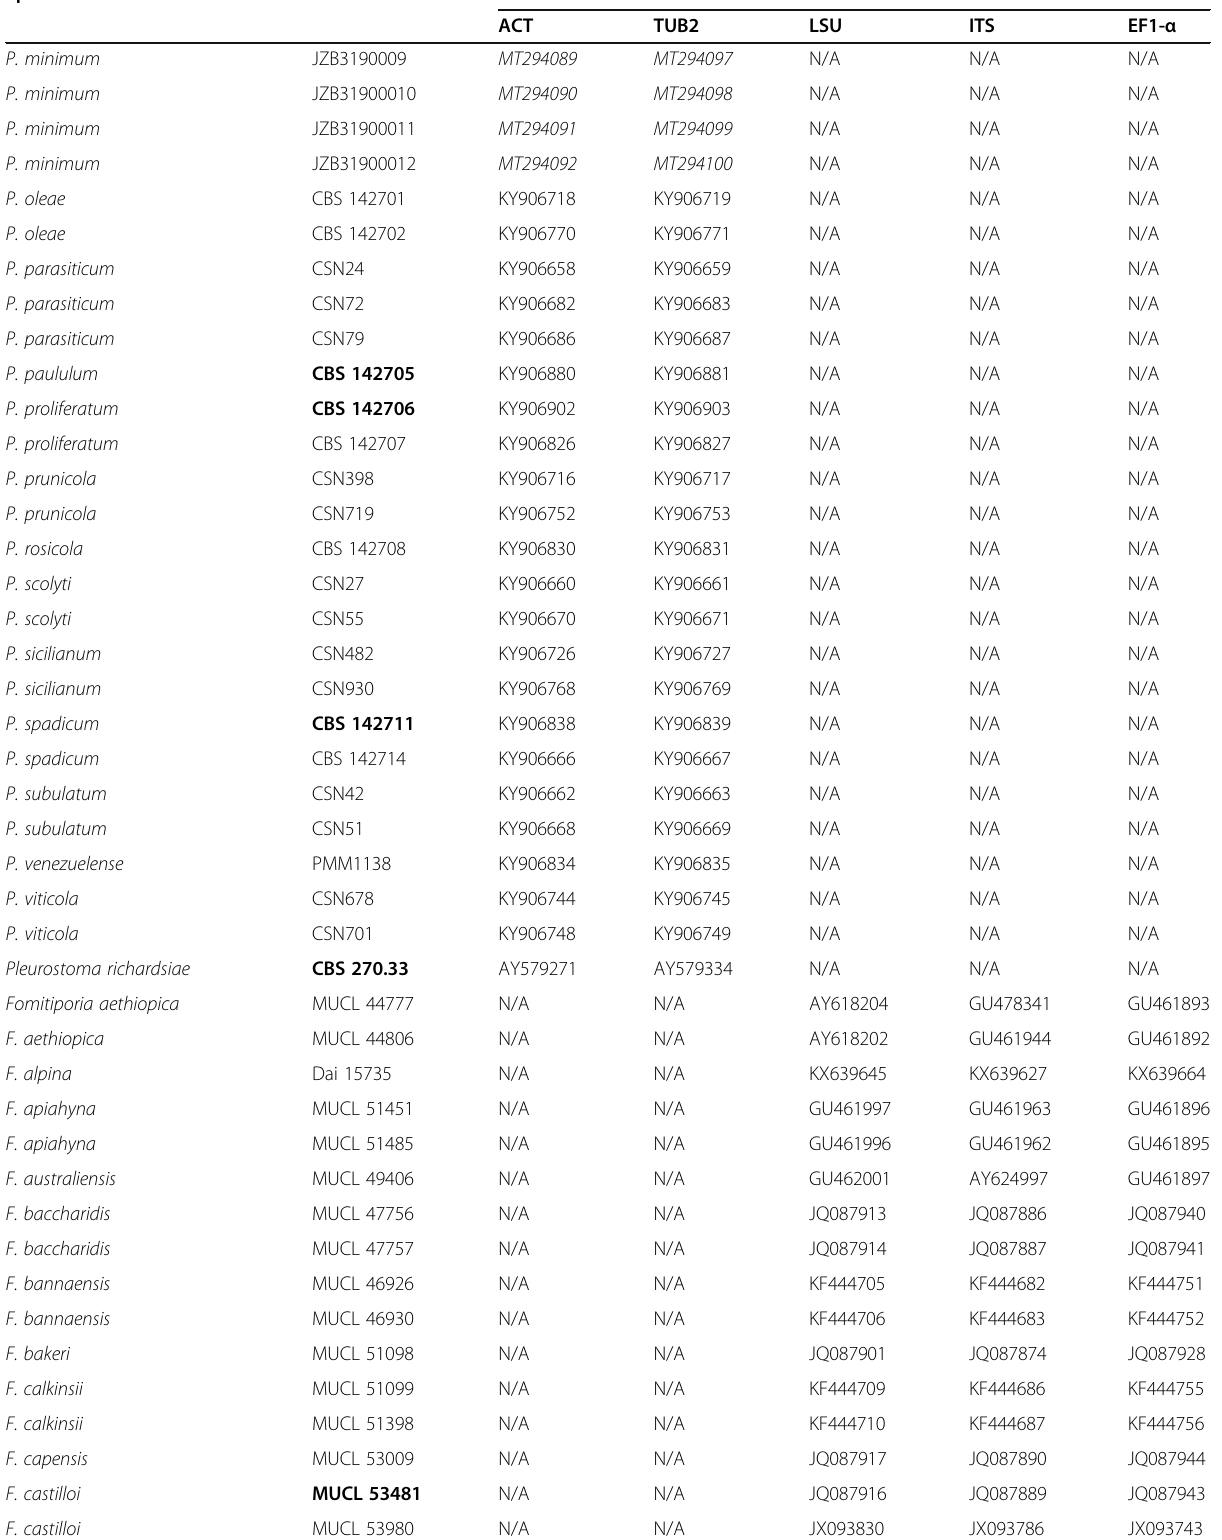
Table 2 Isolates and GenBank accession numbers of Phaeoacremonium and Fomitiporia species in this study (Continued)